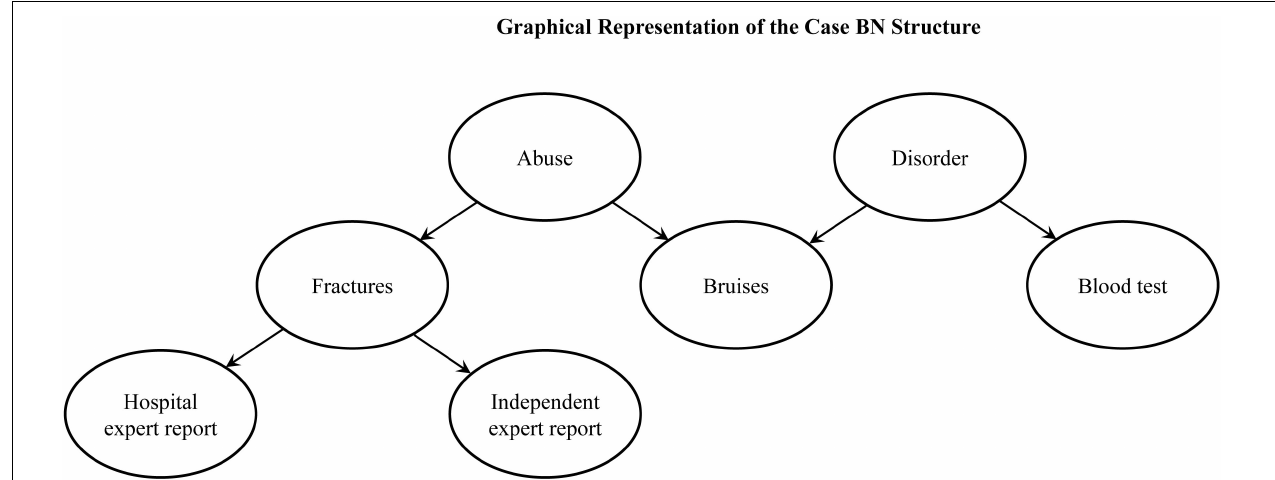
FIGURE 1 | The graph represents the underlying Bayesian Network (BN) causal structure of symptoms and evidence in Experiments 1 and 2.